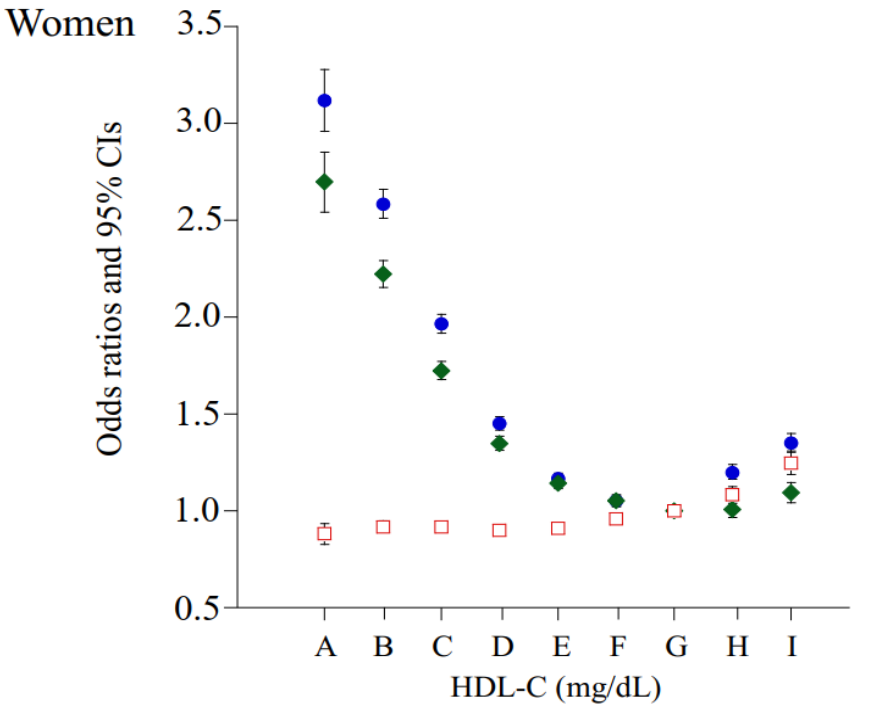
Figure 2. Odds ratios of nine HDL-C concentration categories for HBP. Closed blue circle: unadjusted. Closed green diamond: adjusted for age, sex (whole subjects), smoking, pharmacotherapy (for diabetes mellitus or dyslipidemia), habitual exercise, and daily alcohol consumption. Open red square: plus adjusted for body mass index and serum concentration of triglyceride A, 20–39; B, 40–49; C, 50–59; D, 60–69; E, 70–79; F, 80–89; G, 90–99; H, 100–109; I, ≥ 110 mg/dL. Table 3. Prevalence of HBP according to nine HDL-C concentration categories in subjects who hardly consumed alcohol. HDL-C